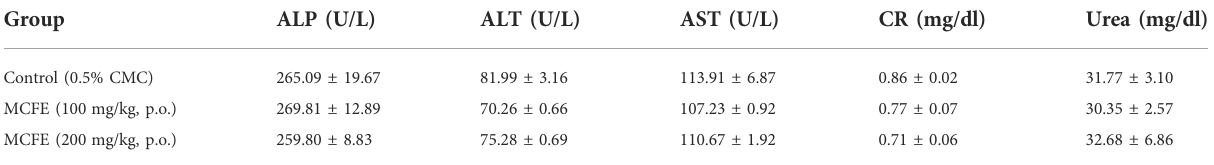
TABLE 5 Measurement of biochemical parameters on chronic administration of MCFE.